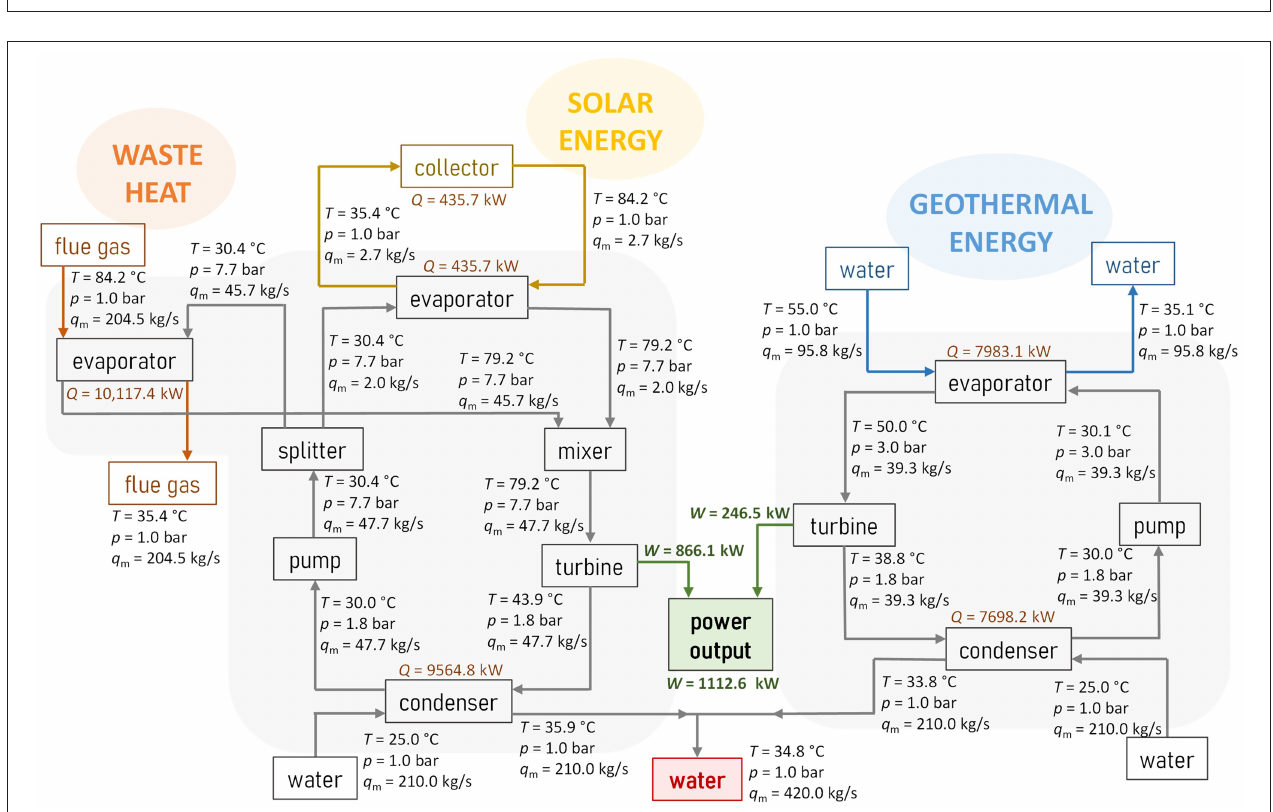
FIGURE 6 | Maximum values of power output regarding heat sources and working fluids for optimized ORC system.